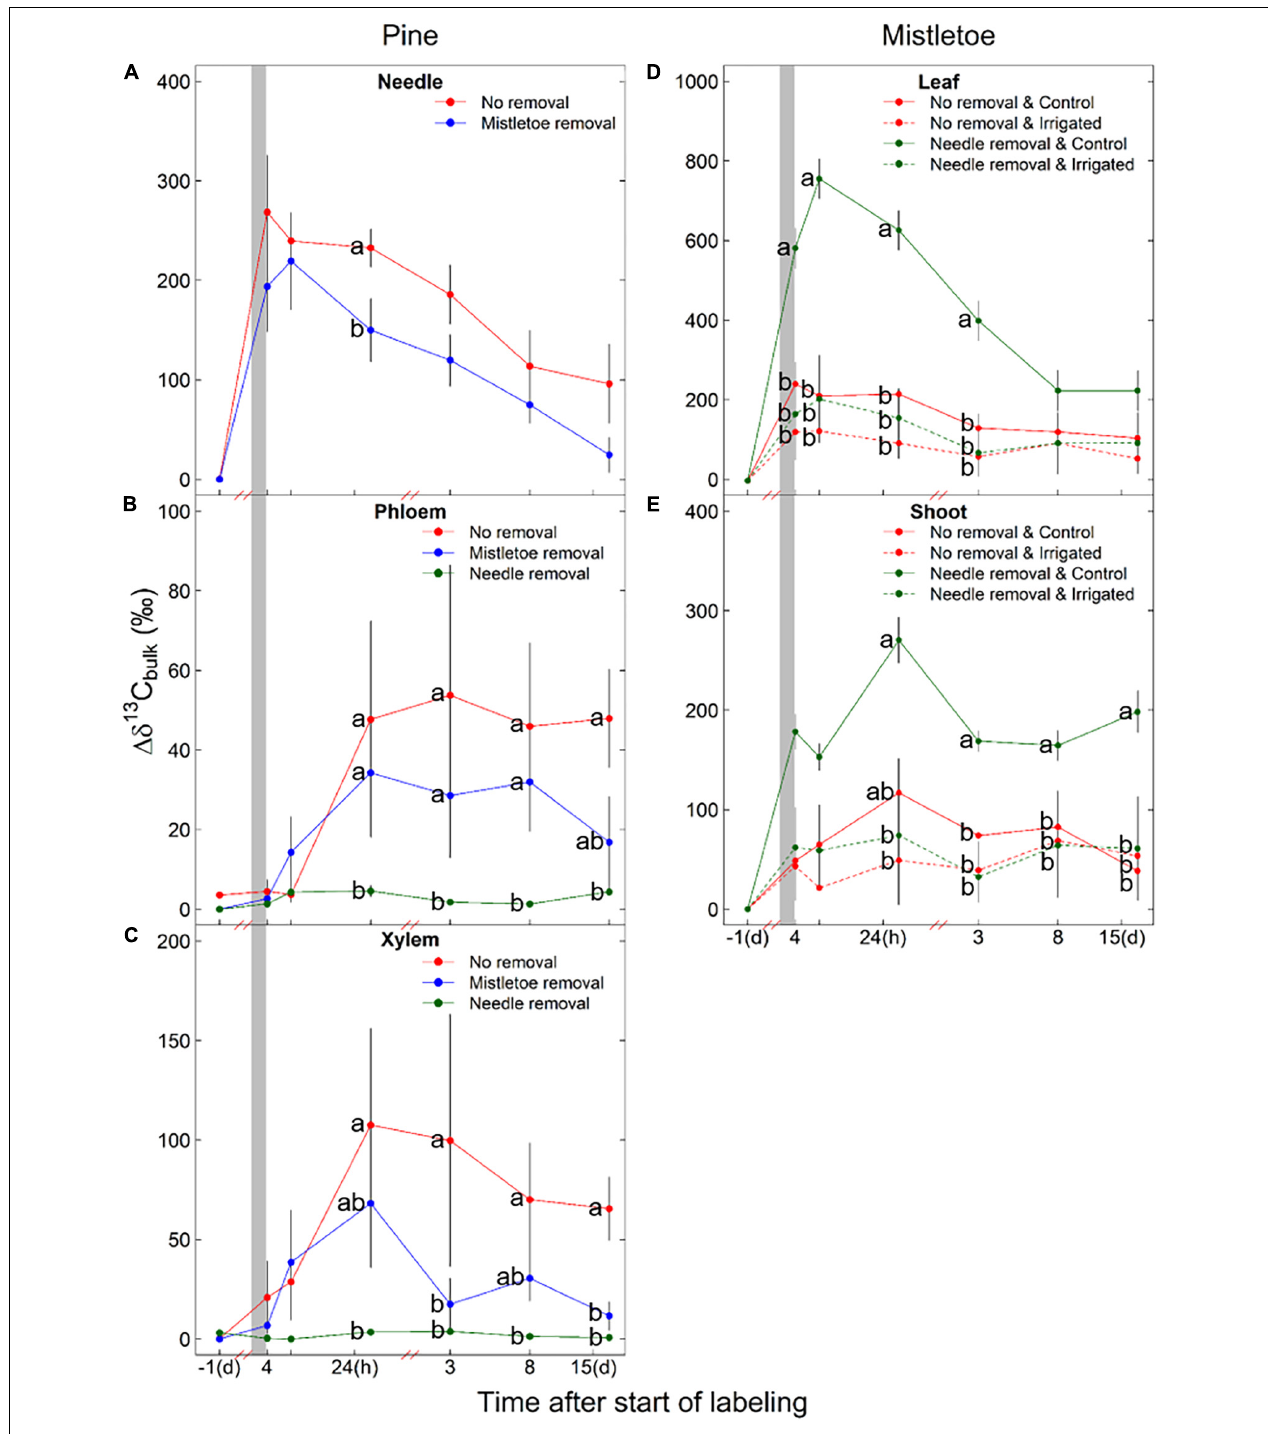
FIGURE 4 | Initial (1 day before the labeling) and incorporation of the 13 C label into the bulk organic matter ( (cid:49) δ 13 C bulk ) of different pine ( Pinus sylvestris ) (A–C) and mistletoe ( Viscum album ssp. austriacum ) (D,E) tissues under different removal treatments (i.e., pine needle removal for pine phloem and xylem, mistletoe leaf and shoot; mistletoe removal for pine needle, phloem and xylem). Girdled branches were exposed to 13 C-enriched CO 2 (shaded area) for 3.5 h. Dashed lines (D,E) are used to indicate where the (cid:49) δ 13 C values of mistletoe leaves and shoots showed a significant difference ( P < 0.05) between irrigated and non-irrigated trees (see Table 2 ). Different letters indicate significant differences among treatments at the same sampling time ( n = 3). Please note the difference in scale of the x -axis before and after the red break points and the difference in y -axis scale among panels.